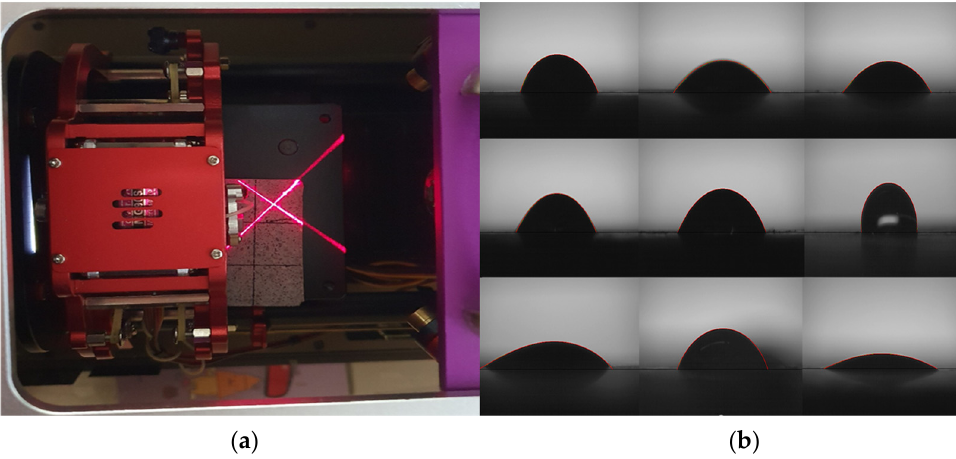
Figure 3. Measurement of the contact angle using the sessile drop method. ( a ) Sessile drop measuring device; ( b ) contact angle measurement result.